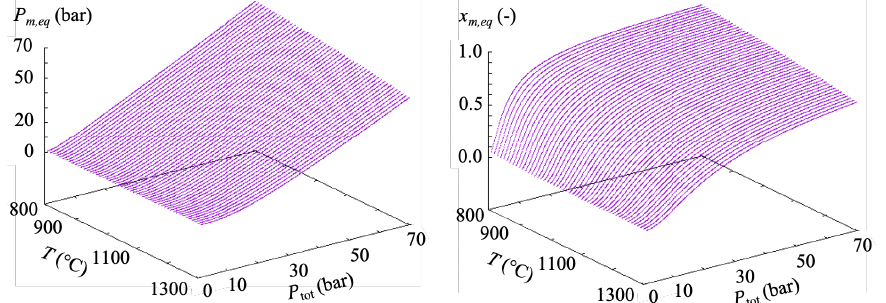
Figure 4. Equilibrium partial pressure of methane ( left ) and equilibrium mole fraction of methane ( right ) for the deposition reaction (1) as a function of temperature and total pressure.